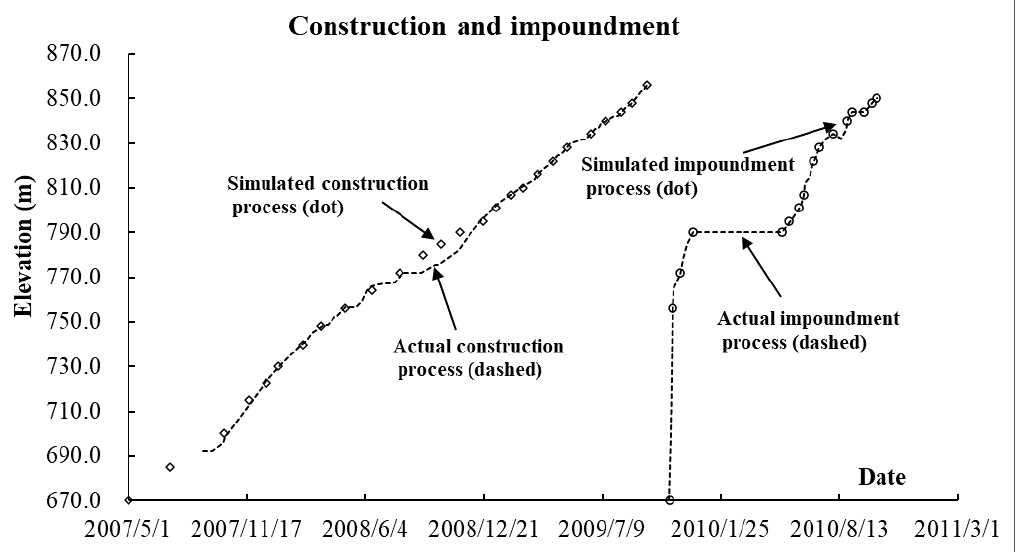
Figure 9. Construction and impoundment process.